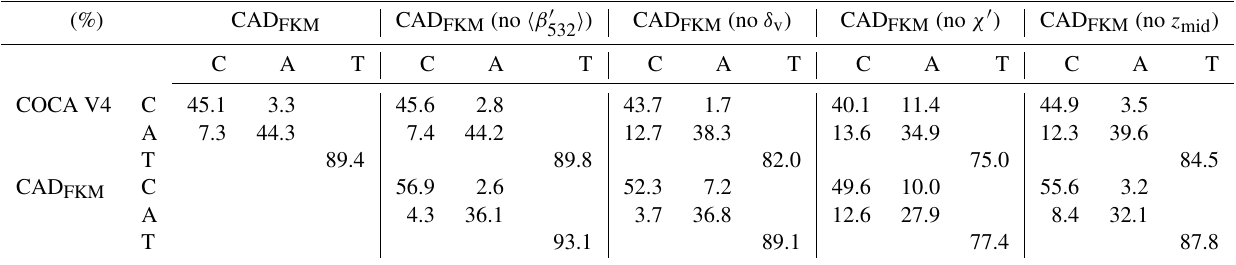
Table 3. Confusion matrices comparing COCA V4 and the CAD FKM results shown in Fig. 11. Abbreviations are as follows: C: cloud, A: aerosol, and T: